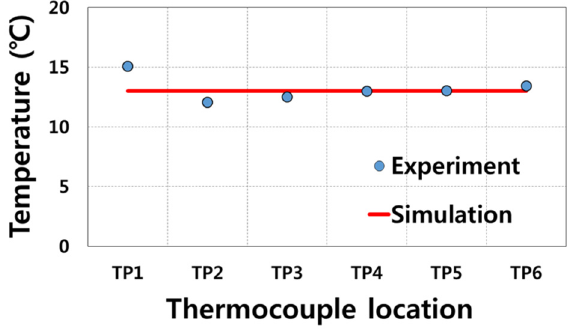
Figure 8. Comparison of the initial temperature condition for finite element simulation against the experimentally measured temperatures at